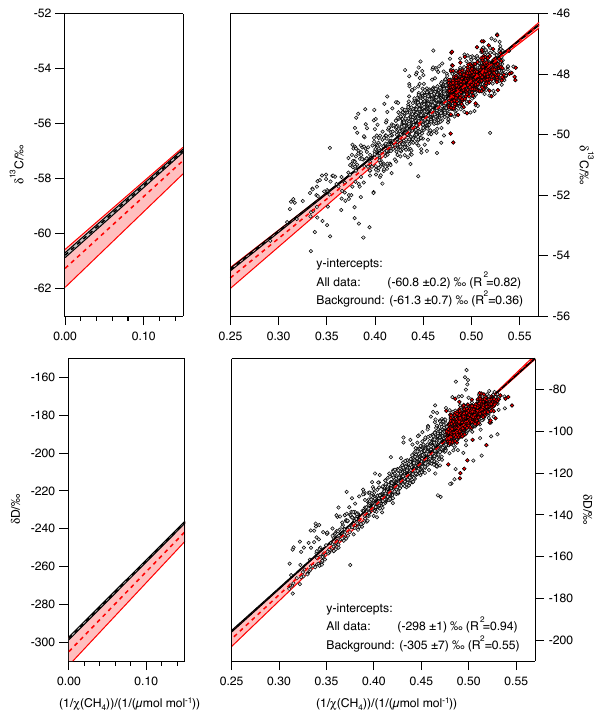
Figure 6. Keeling plot of all data using an orthogonal regression method. The dashed line indicates the regression line and the shaded area the confidence interval taking into account the measurement uncertainties. The color code indicates all measured data (grey points) and daily background values (red points). Left panels show the region near the y axis